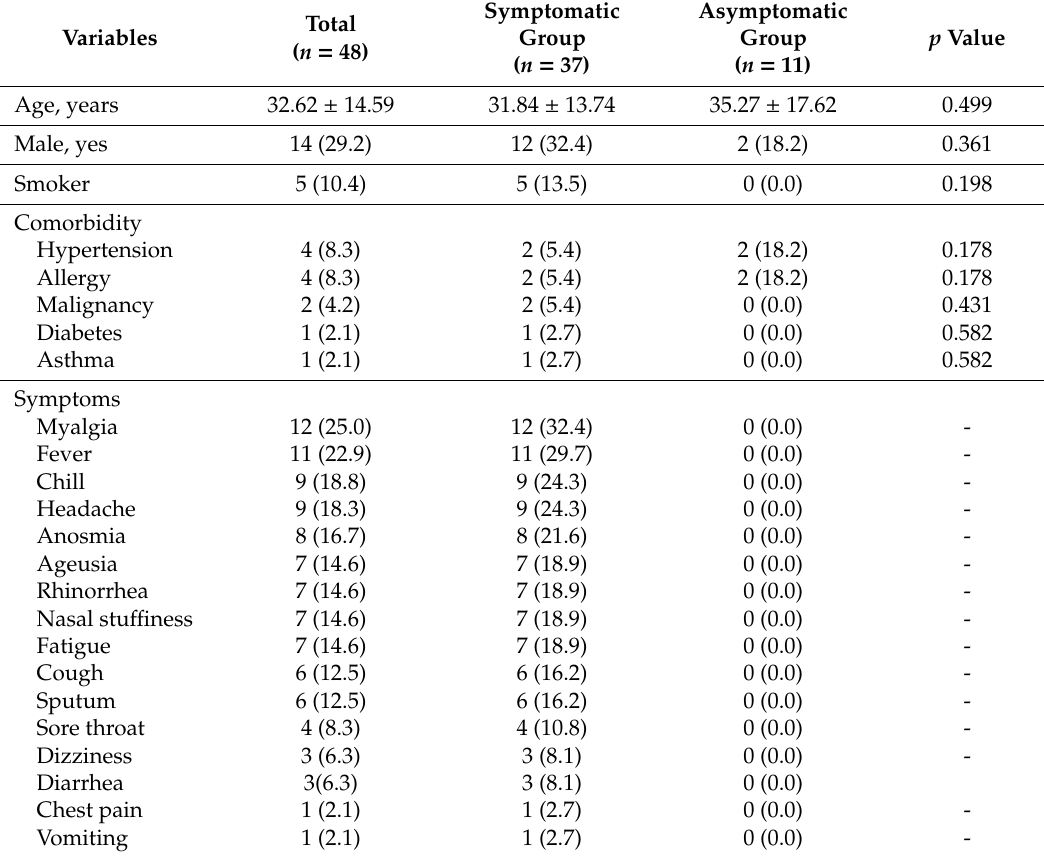
Table 1. Comparisons of demographic and clinical characteristics of asymptomatic and symptomatic patients with COVID-19.